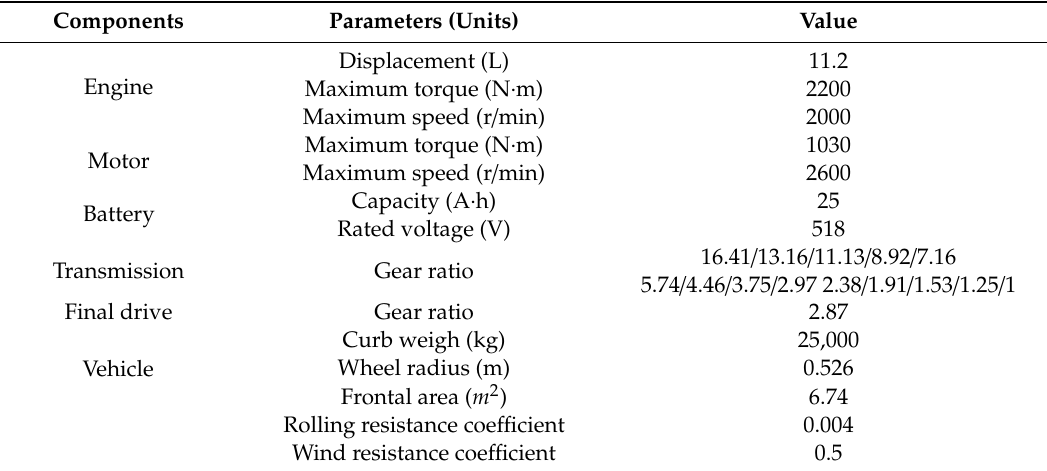
Table 1. Vehicle specifications.